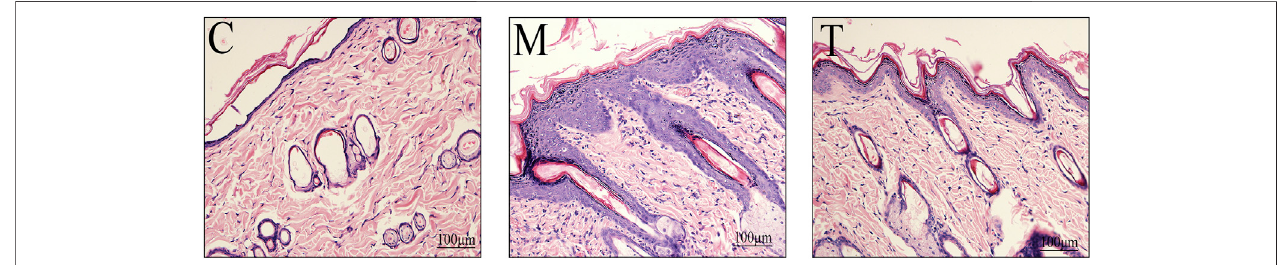
FIGURE 3 | Skin histopathology among the three treatment groups (hematoxylin-eosin, 200 × magni fi cation). C: control rats; M: oleic acid-induced acne rats; T: oleic acid-induced acne + TAN-treated rats.